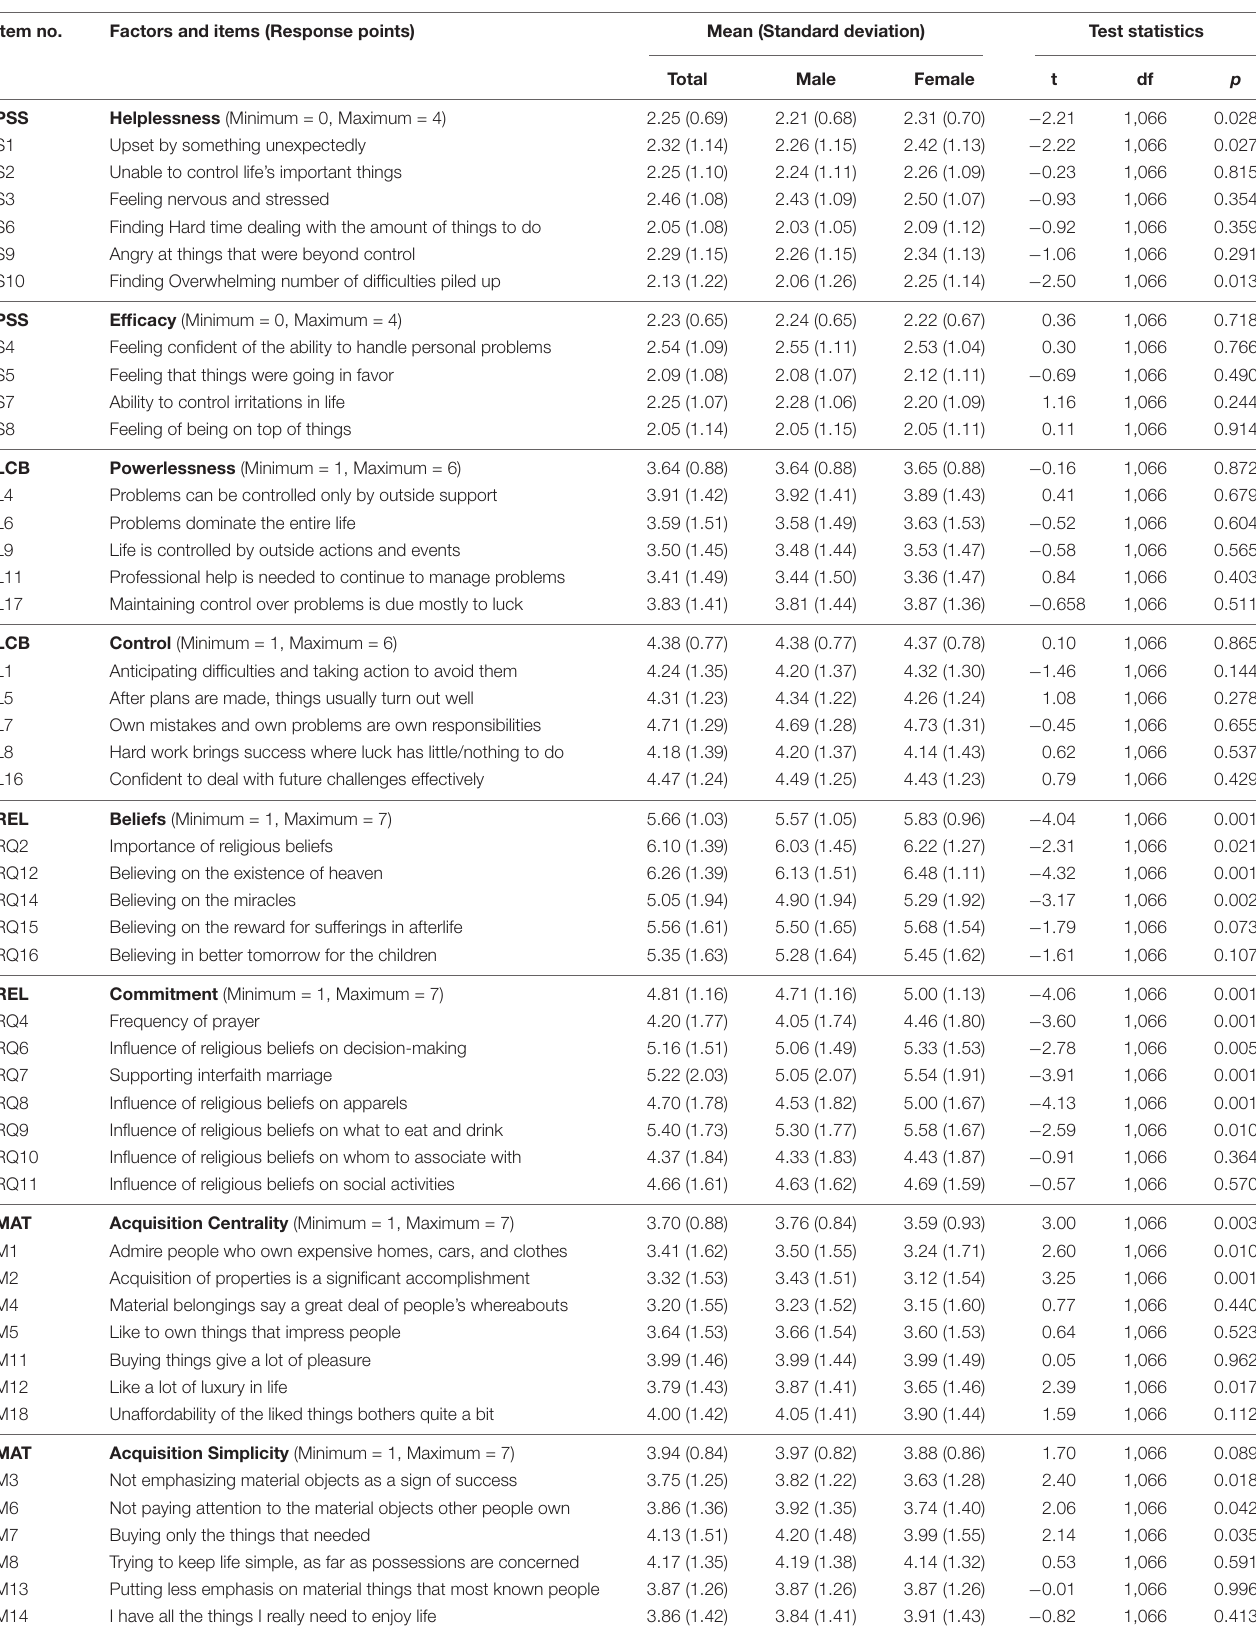
TABLE 4 | Mean ( SD ) and the t -test statistics of men-women differences. Item